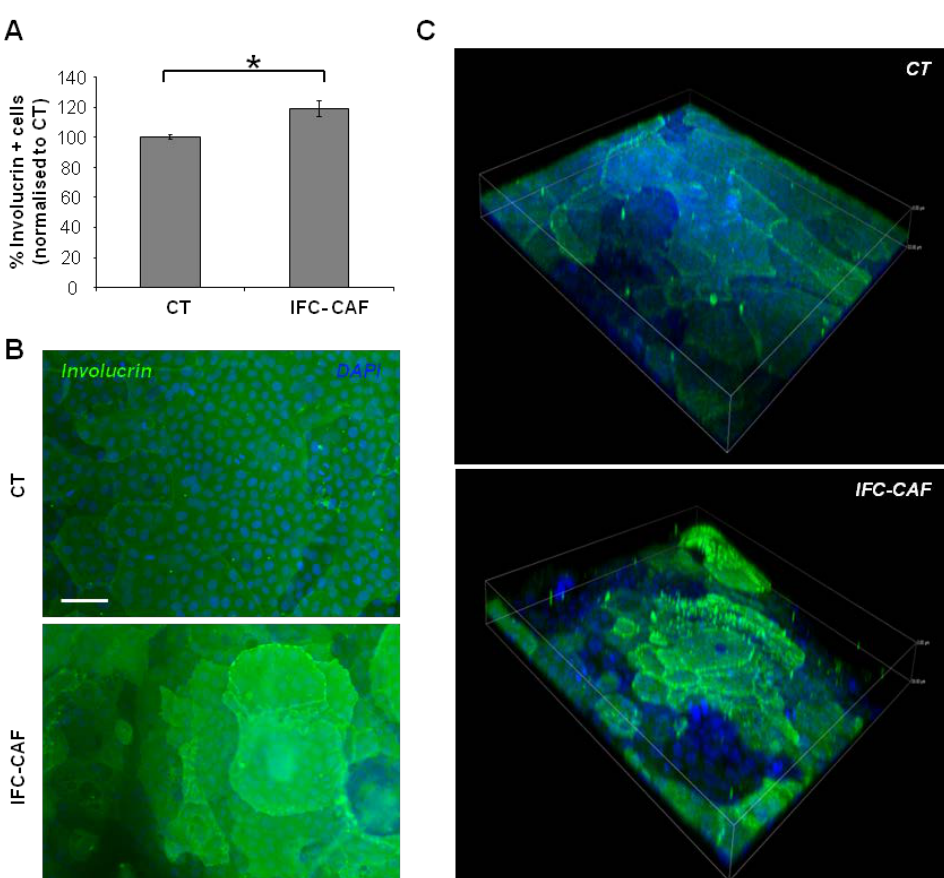
Figure 3. IFC-CAF ® promotes vertical epidermal growth and tissue regeneration by stem cells. ( A ) Flow cytometry analyses of cells either untreated or exposed to IFC-CAF ® (0.9 mg/mL) for 6 days. Percent of positive cells is computed, considering positivity an integrated signal significantly above background (IgGs negative control). Data are mean ± S.D. of duplicate samples representative of two independent experiments. Statistical significance was assessed by Student´s t test (*: p < 0.05). ( B ) Confocal immunofluorescence microphotograph of primary keratinocytes treated as in ( A ); green fluorescent signal corresponds to involucrin and DAPI (blue) was used to visualise nuclear DNA. Scale bar: 50μm. ( C ) Representative 3D reconstruction of vertical serial optical confocal sections of involucrin/DAPI labelling, of samples in ( B ), with same colour code. Z-axis depth: 33 μm.